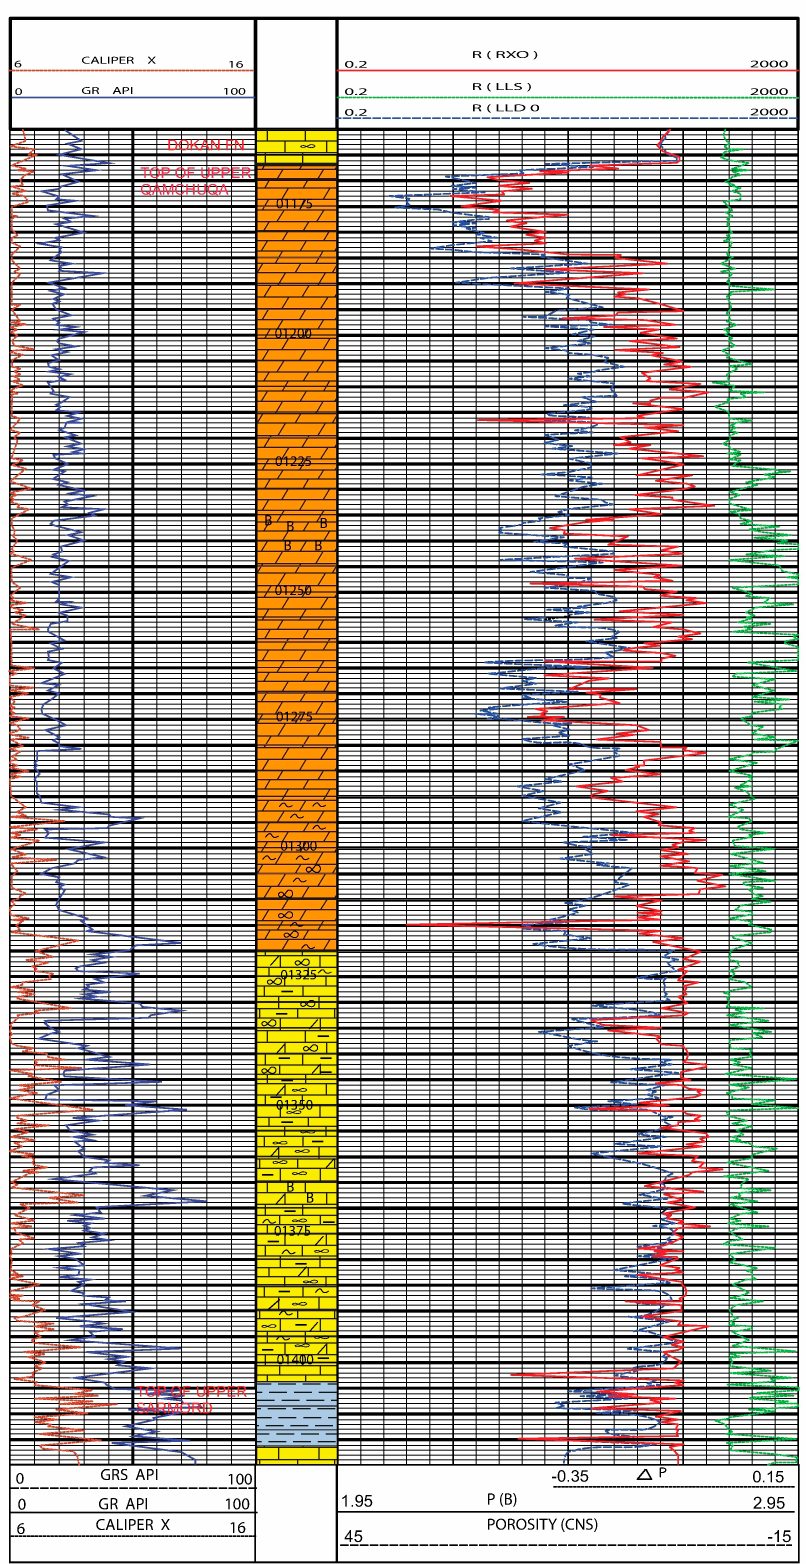
Figure 3. Lithological log for the Upper Qamchuqa Formation. Left-hand track shows gamma ray (GR) and API of the reservoir. The recent studied samples represented the depth interval from 1175 m to 1191